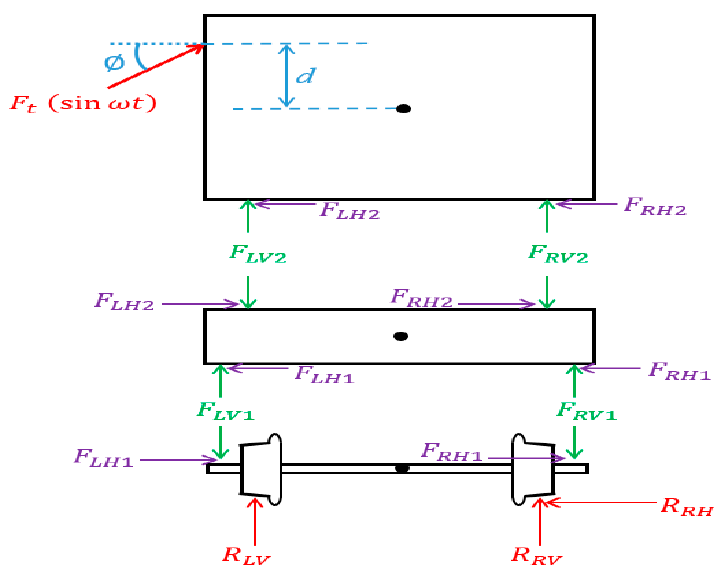
Figure 5. The wind force with a frequency component.